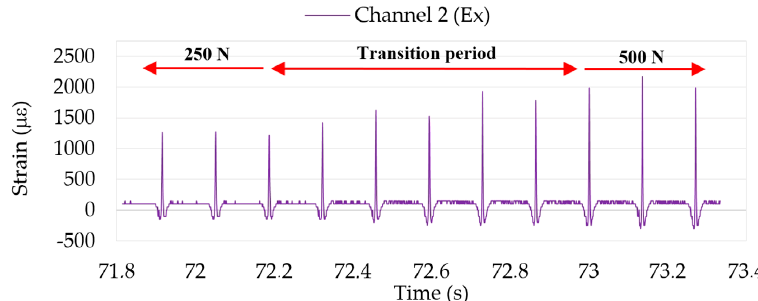
Figure 6. Strain data changes in Channel 2 for different vertical loads.